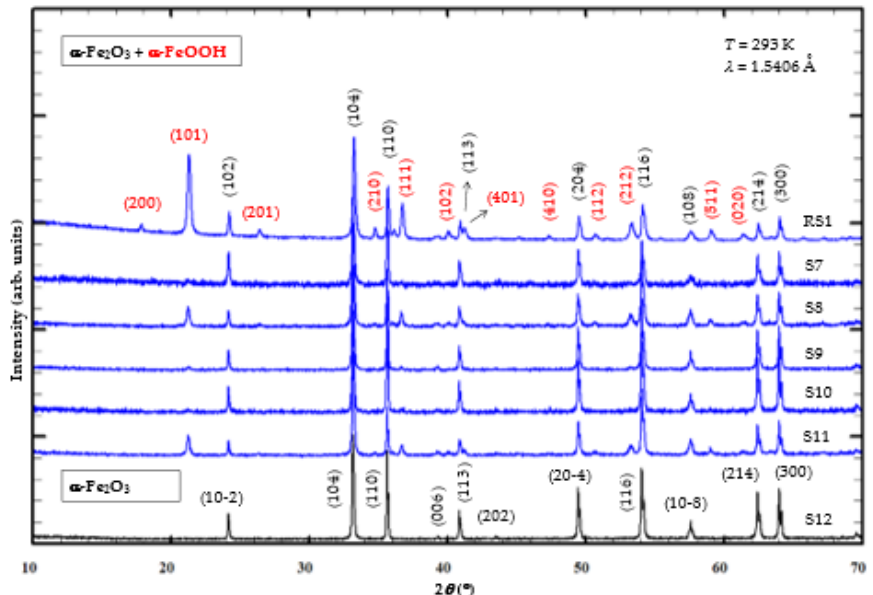
Figure 5. Cascade PXRD patterns of the reference sample RS1 and samples S7–S12 prepared with addition of essential oils at 200 °C.